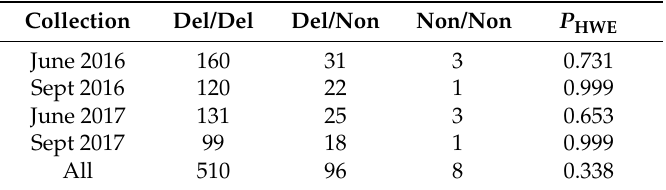
Table 2. Genotype counts of the MtnA 3’ UTR indel